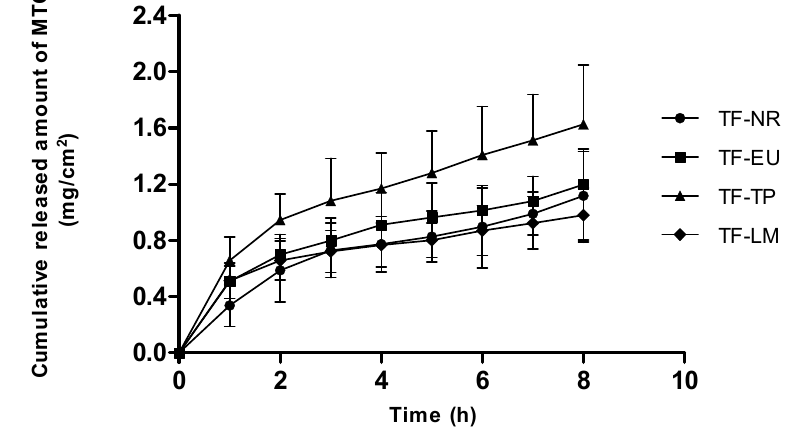
Figure 5. In vitro release of MTC from transdermal film formulations.